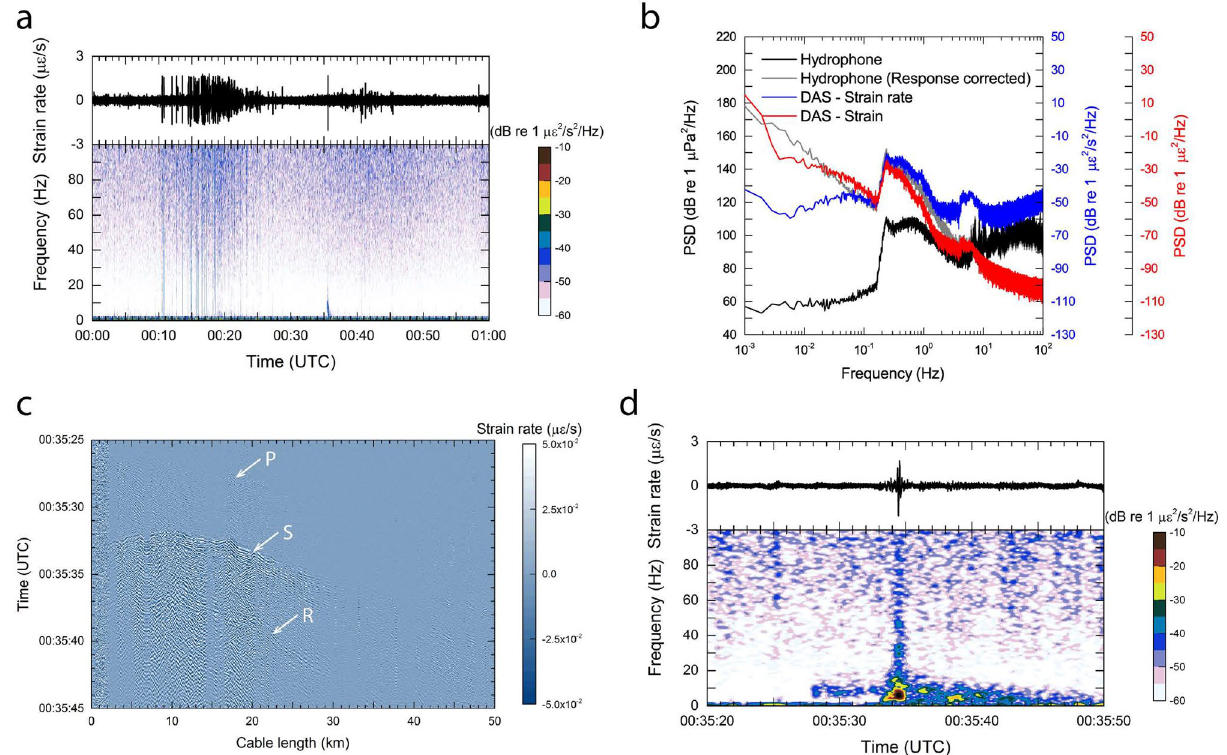
Figure 4. DAS recordings associated with the ambient noise and an earthquake. ( a ) Time series recording and its spectrogram of 1 h recording (a period of 00:00s UTC on 02 December 2019) at a cable length of 20.8 km. 1-s time window, 1-Hz frequency resolution and 90 % over-lap time are used. ( b ) Power spectral densities (PSDs) comparing the DAS measurement and the co-located hydrophone. Note that the PSD of the hydrophone corrected with the sensor’s response (gray line) is synthesized by extrapolation of a low frequency range down to 10 − 3 Hz using the same modeling procedure 43 . ( c ) DAS recording of the entire Muroto cable during a regional earthquake with magnitude of 1.7. Band-pass filter between 2 and 20 Hz is applied. Arrows denoted by P, S, and R represent the arrivals of seismic P-, S-, and Rayleigh- waves identified by the authors, respectively. ( d ) Time series recording and its spectrogram at a cable length of 20.8 km during the earthquake. Note that the 1-s time window is the same to ( a ), but frequency resolution and over-lap time are 0.1 Hz and 96 %,